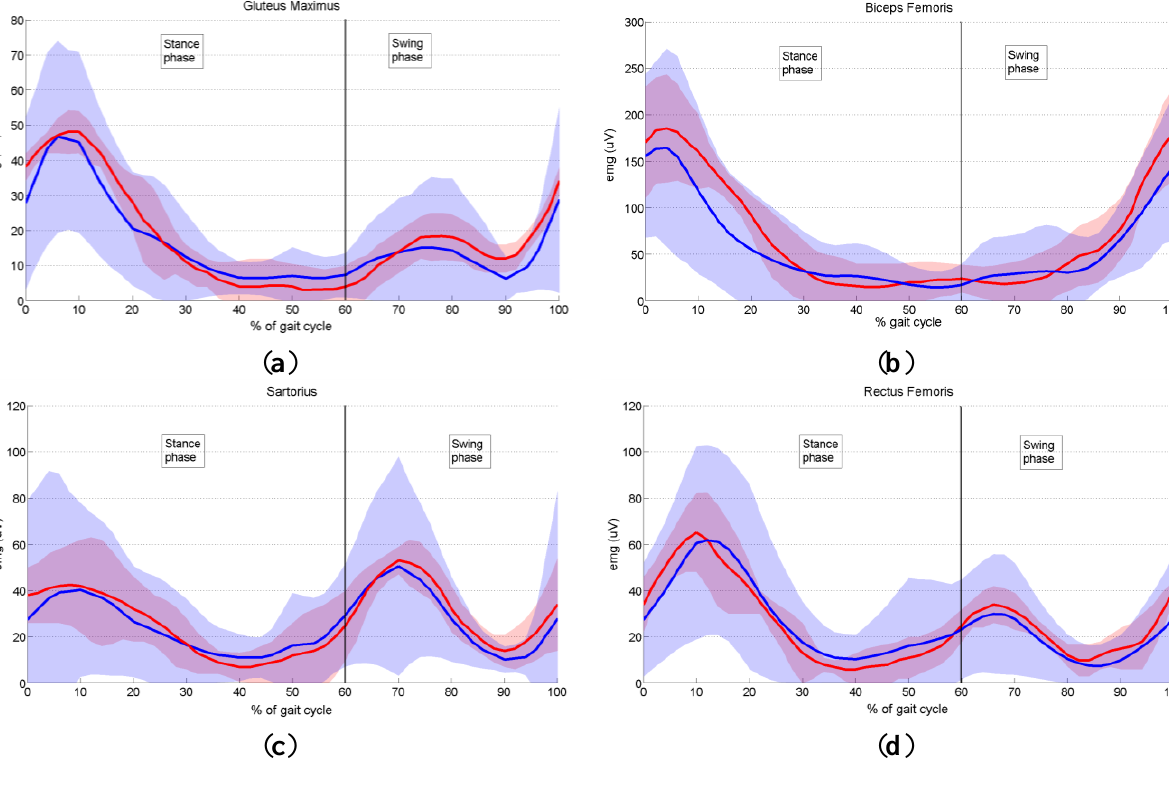
Figure 17. Average EMG activity of measured muscles during one gait cycle. Comparison of EMG data (± SD) measured by our EMG system (red lines ± red shaded area) and EMG reference data from the literature [29] (blue lines ± blue shaded area). ( a ) Average EMG activity of gluteus maximus during one gait cycle; ( b ) Average EMG activity of biceps femoris during one gait cycle; ( c ) Average EMG activity of sartorius during one gait cycle; ( d ) Average EMG activity of rectus femoris during one gait cycle; ( e ) Average EMG activity of tibialis anterior during one gait cycle; and ( f ) Average EMG activity of medial gastrocnemius during one gait